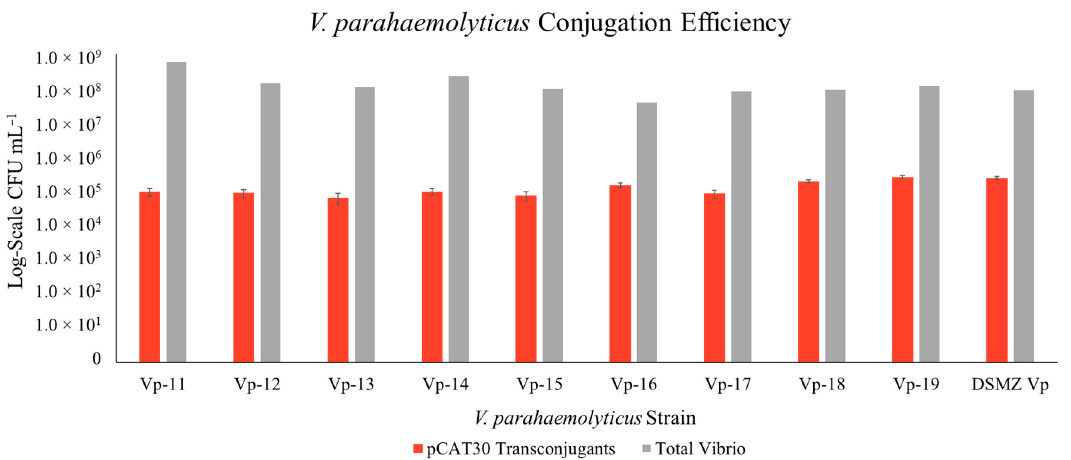
Figure 5. The conjugation efficiency of pCAT30 with V. parahaemolyticus . Red bars represent the V. parahaemolyticus transconjugants that grew on selective LB agar supplemented with 50 μ g mL − 1 and the grey bars represent the total Vibrio colonies enumerated on non-selective MB agar